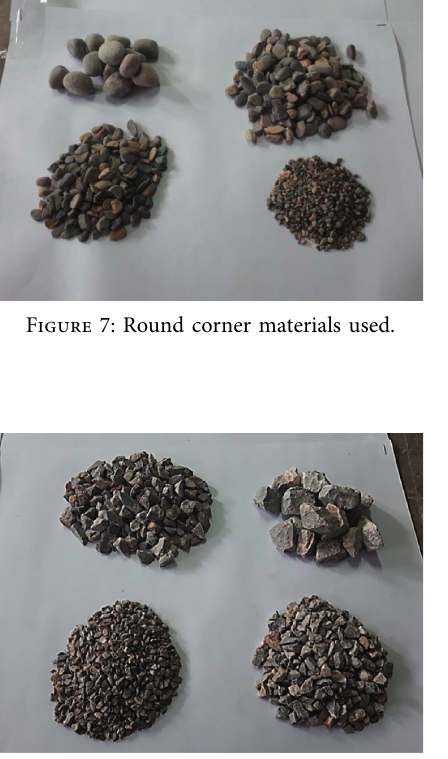
Figure 8: Sharp corner materials